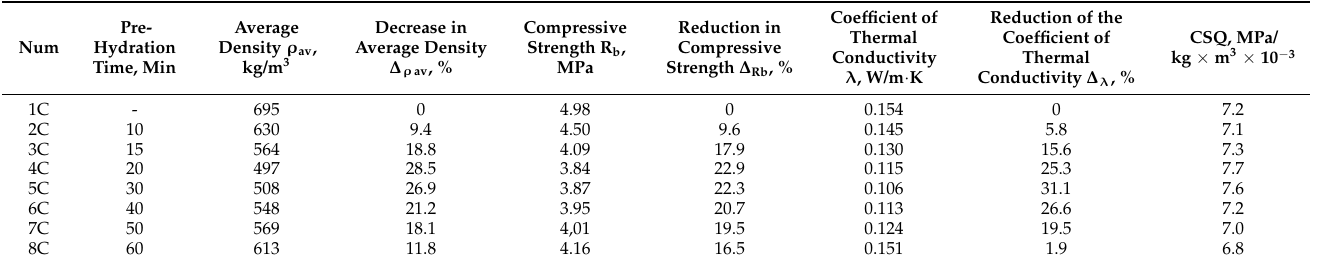
Table 4. Physical and mechanical properties of aerated concrete and their change depending on the time of preliminary hydration of the binder.